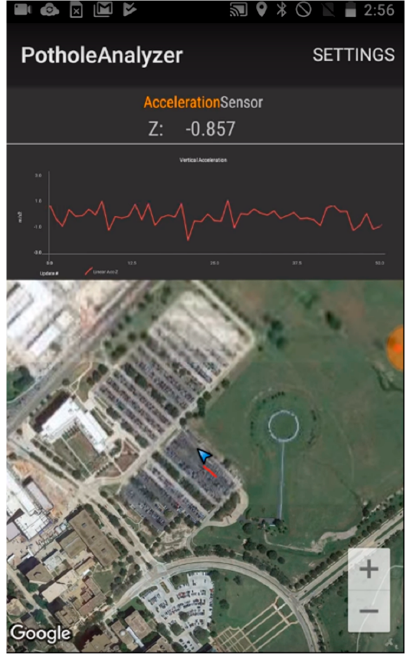
Figure 2. The user interface of PotholeAnalyzor .